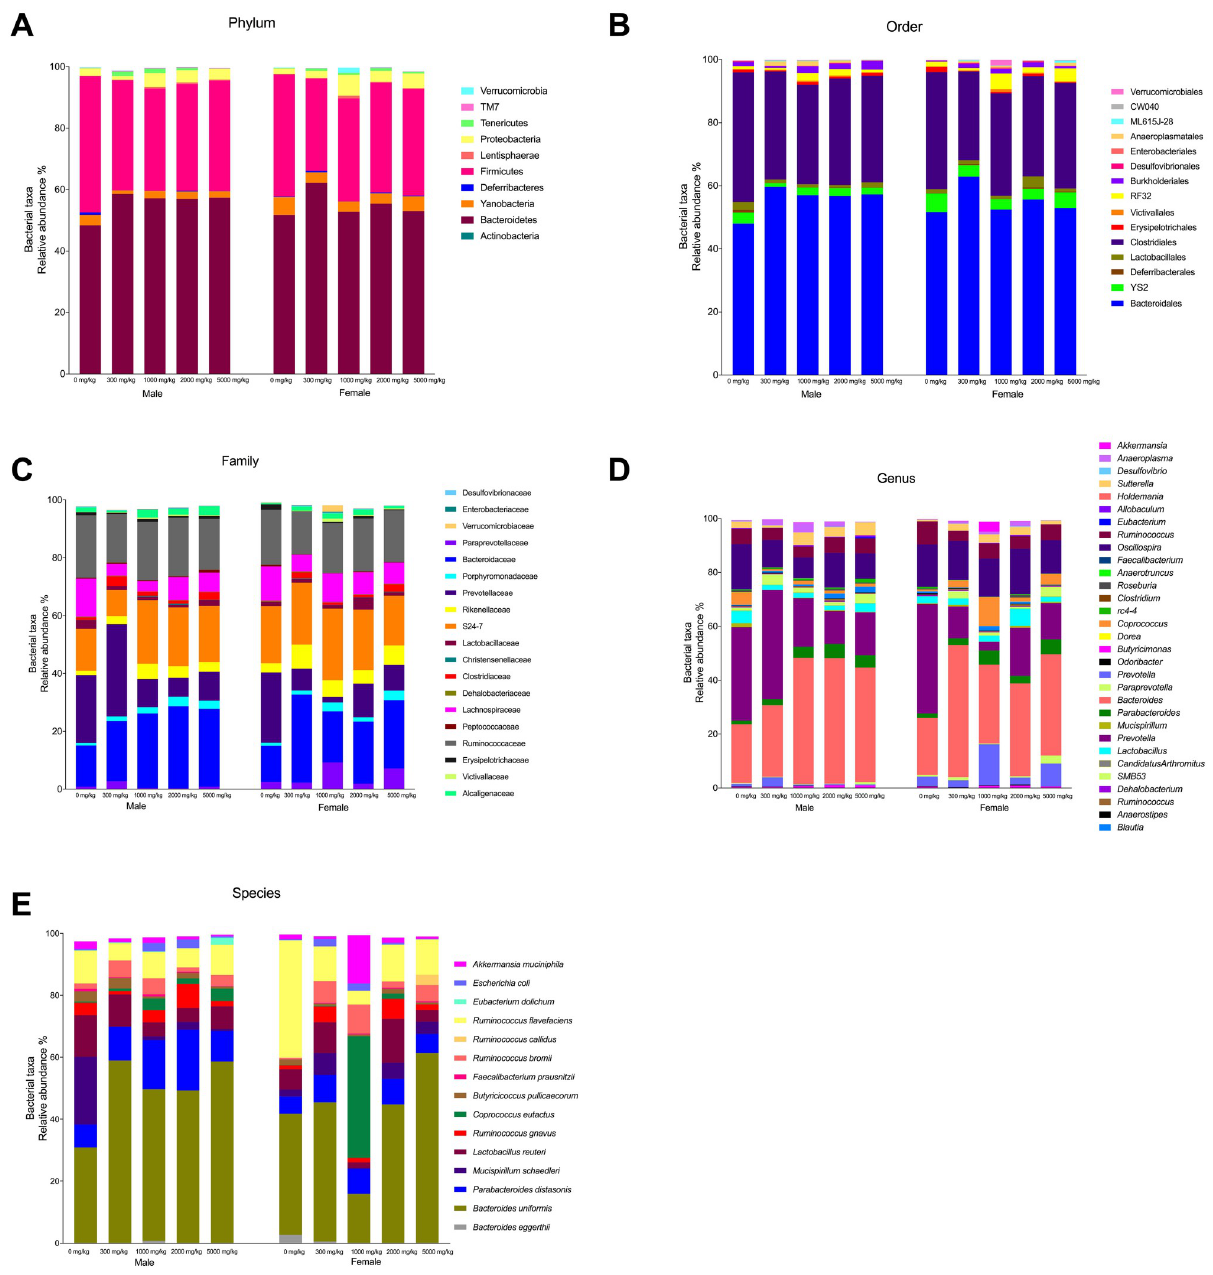
Fig 15. Effect of different doses of standardized Gl -1 extract of Ganoderma lucidum on the taxonomic distribution of bacterial communities from the gut microbiota of male (M) or female (F) Wistar rats for 14 experimental days. Main average bacterial relative abundance (BRA) is presented at the following taxonomic ranks: Phyllum (A), Order (B), Family (C), Genus (D), and Species (E). The dose administered per experimental group is described in the materials and methods section. Scientific names according to international database (http://www.catalogueoflife.org/).